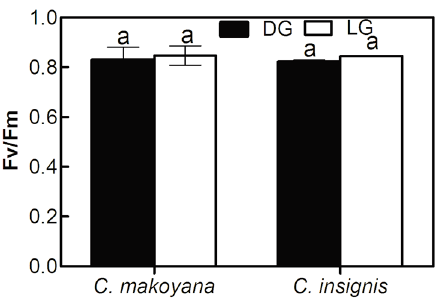
F igure 2 Figure 2. Fv/Fm value of dark green (black bar, DG) and light green (white bar, LG) leaf sectors in Calathea makoyana and C. insignis . Vertical bars indicate the standard deviation ( n = 5). The same characters represent no significant difference ( p <